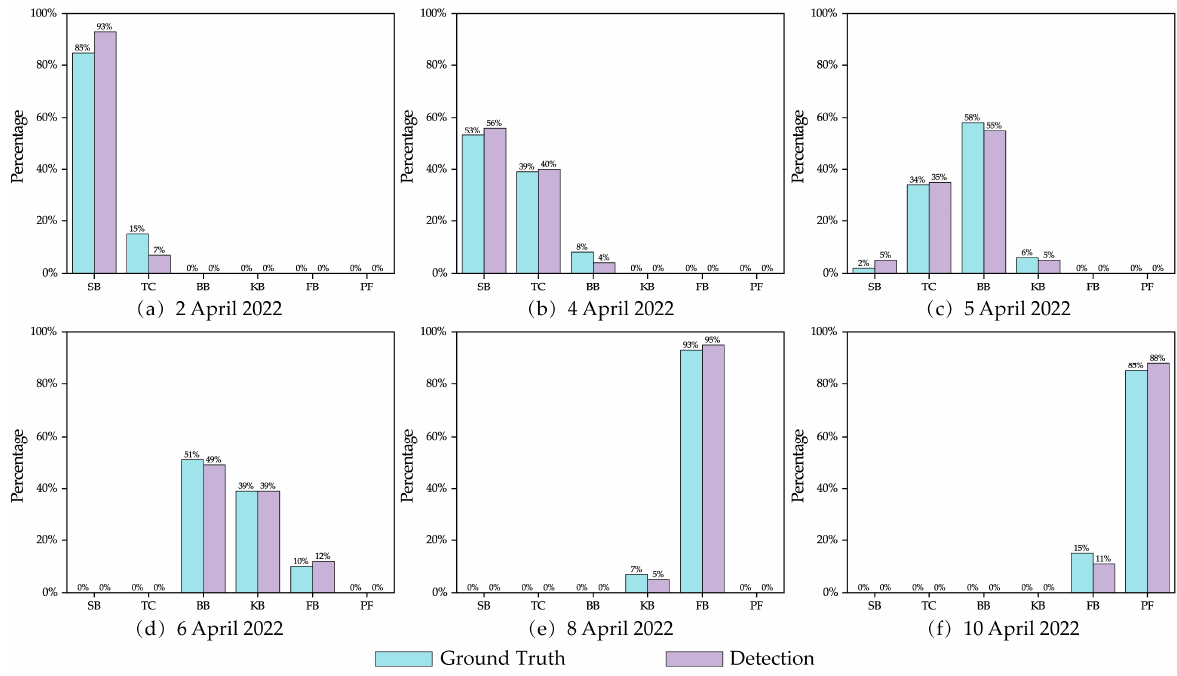
Figure 12. Results of blooming level